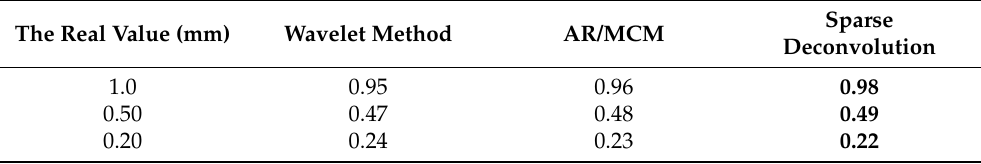
Table 1. The comparison of calculated thickness from three